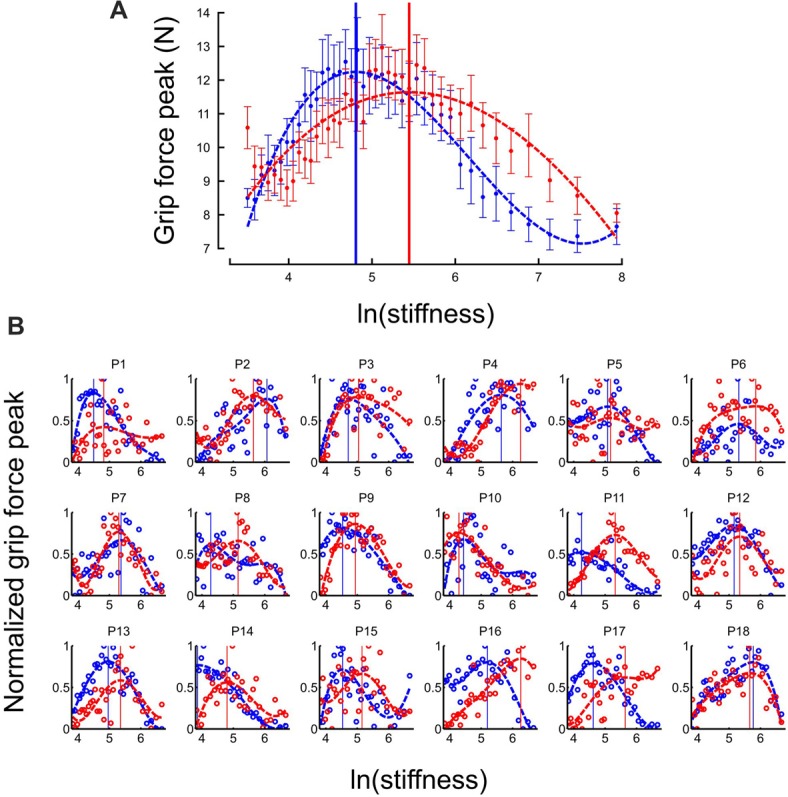
Grip force is adapted to stiffness. (A) Distribution of grip force maximum (averaged across participants) in function of ln(stiffness) in “Ascending” (red trace) and “Descending” block conditions (blue trace). The dashed lines are the best fourth order polynomial fits of each series. Goodness of fit: r2 = 0.72 in “Ascending” condition and r2 = 0.84 in “Descending” condition. The vertical cursors are positioned at peak grip force (“Ascending”: 5.07; “Descending”: 4.89, which correspond to stiffness of 159.7 N/m and 133.2 N/m, respectively). Error bars are between participants SE. (B) Individual normalized plots showing the same behavior at the participant level (except for participant 14 in the “Descending” condition).